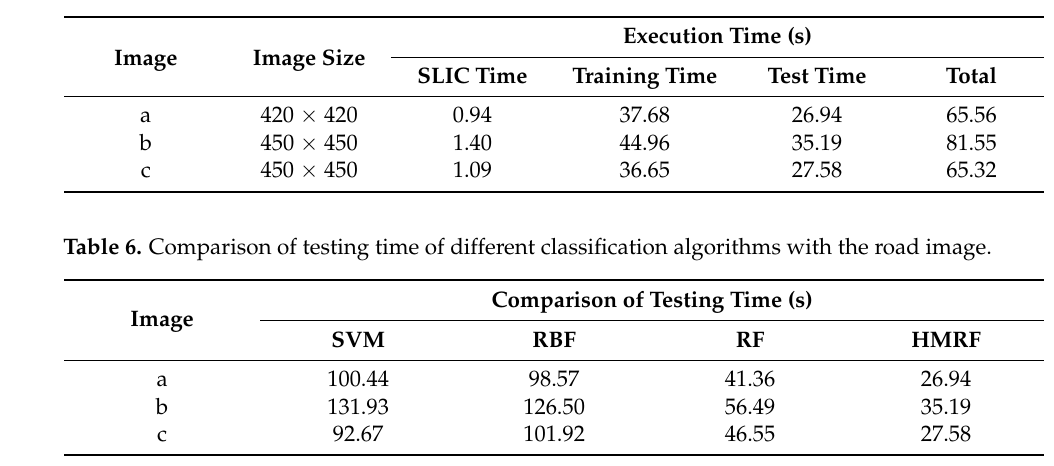
Figure 5. The mean quantitative assessment results of local dataset road images for common classifi- cation algorithms. Table 5. The execution time of proposed classification model HMRF in the local dataset.